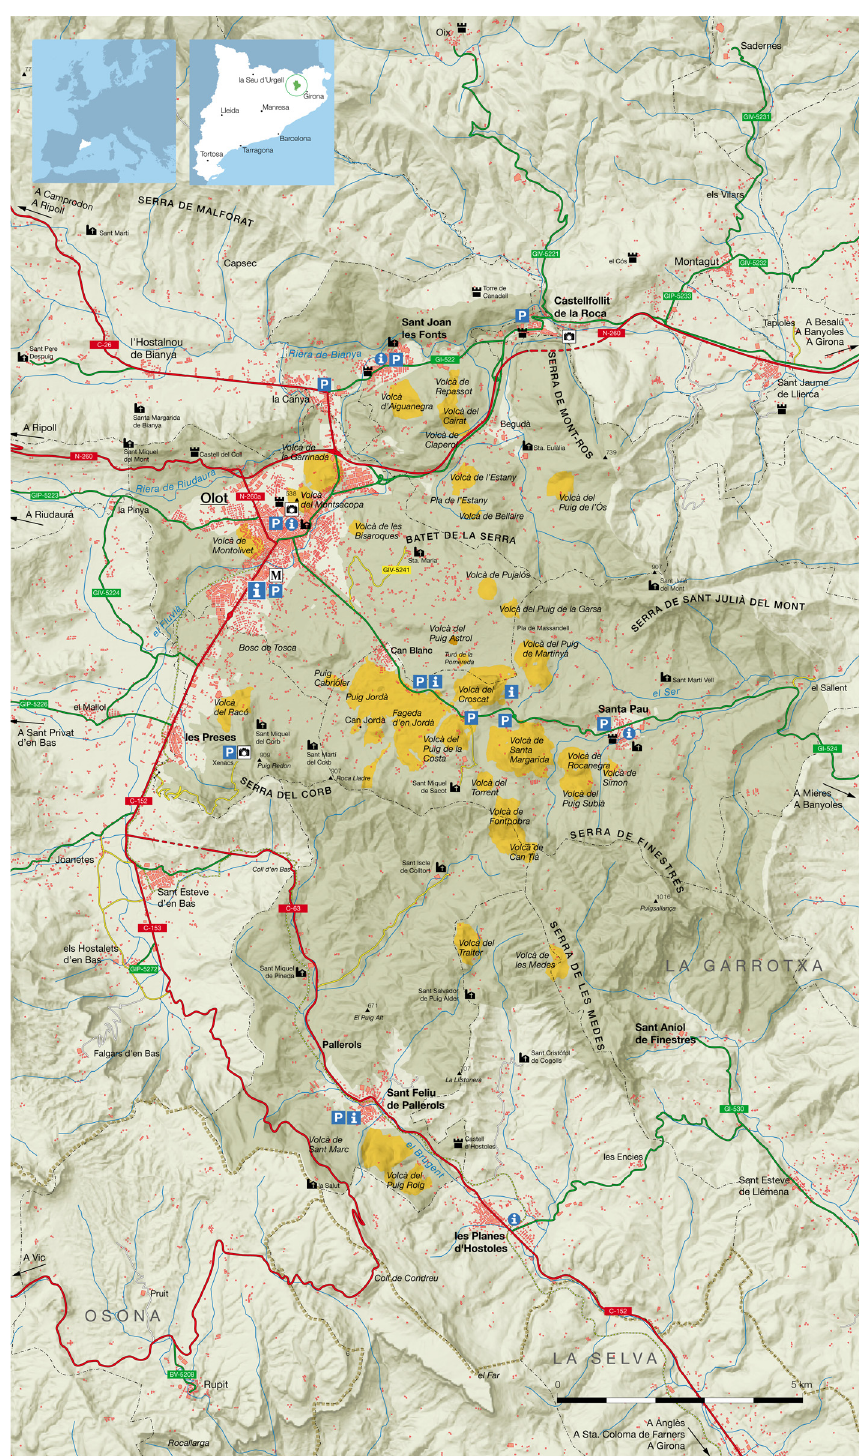
Figure 1: Map of the Natural Volcanic Park of la Garrotxa. Source: Parc Natural de la Zona Volcànica de la Garrotxa, Plànol